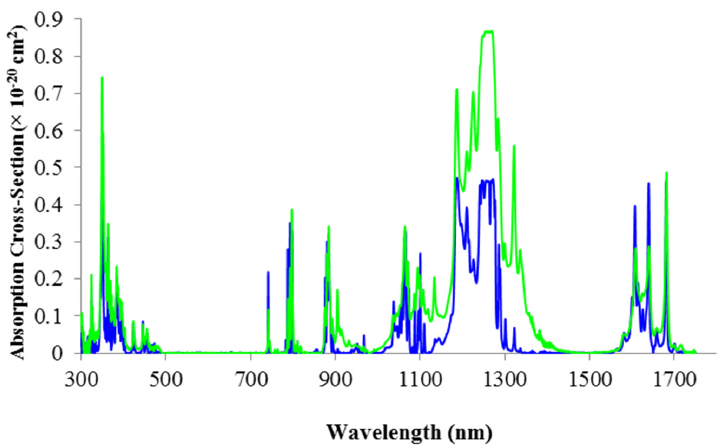
Figure 43. Absorption cross-section as a function of wavelength for a hydrothermally-grown Dy 3+ :Lu 2 O 3 crystal at 80 K (blue) and 298 K (green).